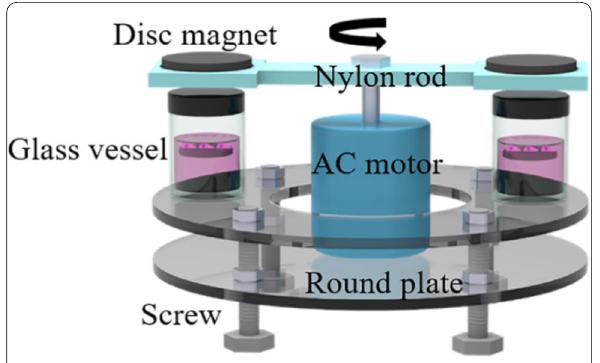
Fig. 2 Schematic representation of the experimental